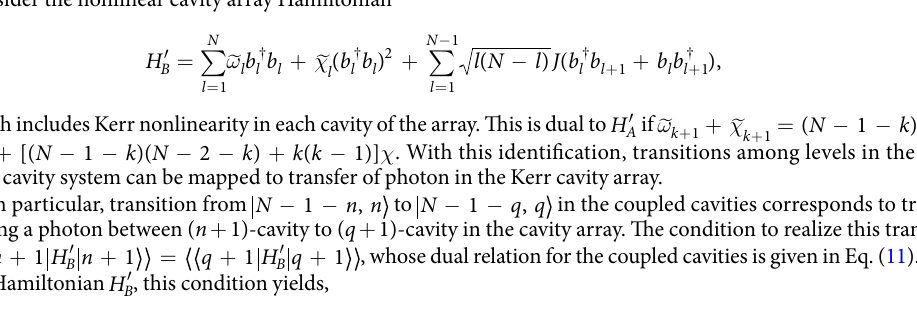
sa na . Here λ sa and λ na are the eigenvalues of ′ H correspond- A ing to the approximate eigenvectors | X + 〉 and | X − 〉 respectively. At π λ λ = − t /( ) sa na , the time-evolved state is | p , q 〉 . This is the minimum time required to switch from | m , n 〉 to | p , q 〉 . Thus, the state switching (SS) condition given in Eq. (10) ensures that there is complete transfer from the initial state | m , n 〉 to the desired final state | p , q 〉 .